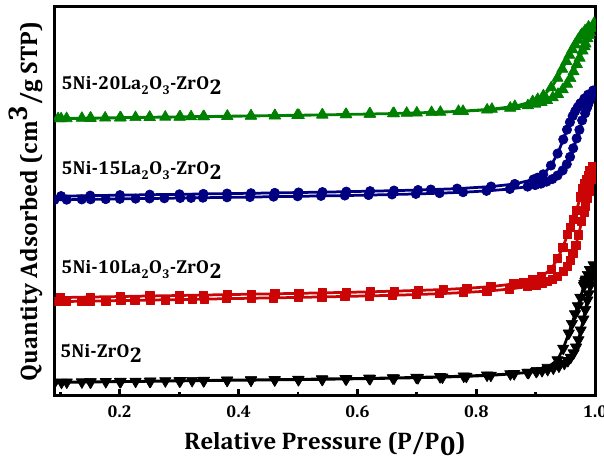
Figure 1. Nitrogen physisorption isotherms of 5Ni-ZrO 2 , as well as lanthanum-promoted 5Ni-ZrO 2 samples.